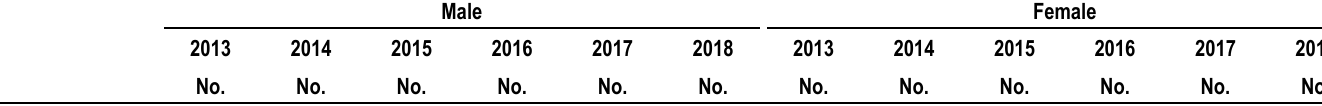
Table 9b. Diagnoses of HIV infection attributed to heterosexual contact, by selected characteristics, 2013–2018—United States and 6 dependent areas